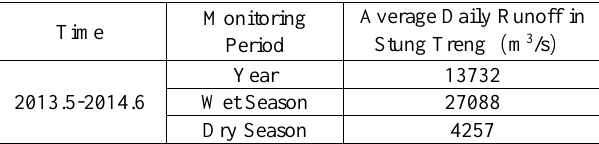
Table 3. Averaged daily runoff in Stung Treng